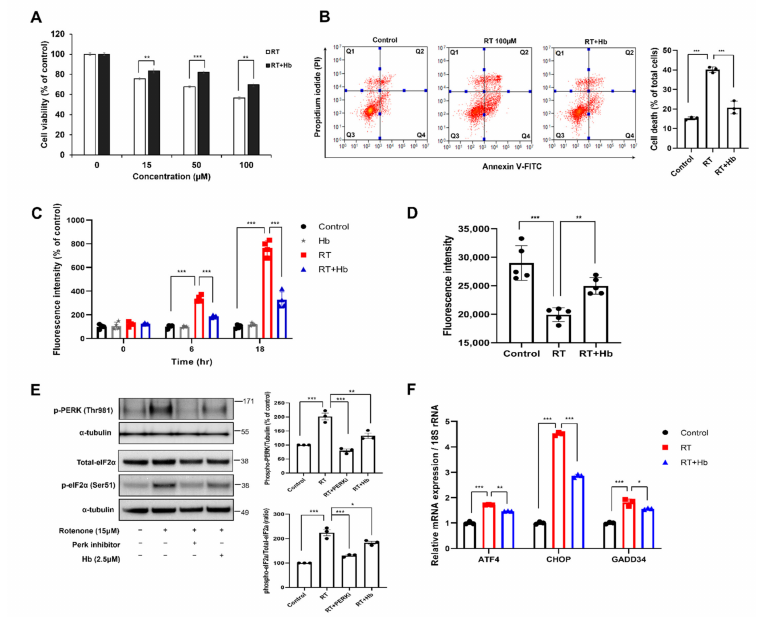
Figure 1. Hydroxocobalamin suppresses rotenone-induced PERK-eIF2 α phosphorylation in SH-SY5Y cells. ( A , B ) SH-SY5Y cells were pretreated with 2.5 µ M Hb for 30 min and then subsequently cultured with various concentrations of rotenone for 24 h. ( A ) Cell viability was measured using a CCK-8 assay. Data are presented as the mean percentages of untreated controls ± SD of three independent experiments. *** p < 0.001 (unpaired Student’s t test). ( B ) Representative flow cytometry plots obtained using Annexin V-FITC/PI staining for cell death analysis. Each cytogram was divided into four quadrants. Q1: Populations of Annexin-V-negative and PI-positive cells considered necrotic cells. Q2: Both Annexin-V-positive and PI-positive cells were marked and represent a later stage of apoptosis and necrosis. Q3: Negative for both Annexin-V and PI, indicating cells considered viable. Q4: Cells positive for Annexin-V and negative for PI that are presumed to be undergoing an early stage of apoptosis. The percentage of cell death is expressed as the sum of quadrants Q1, 2 and 4. Data are presented as the means ± SD of three independent experiments. Statistical analyses were performed using one-way ANOVA followed by Tukey’s multiple comparison test (*** p < 0.001). ( C – E ) SH-SY5Y cells were preincubated with Hb (2.5 µ M) for 30 min and subsequently treated with rotenone (15 µ M) for 18 h. ( C ) Intracellular ROS production was detected using the dye DCF-DA, and the results are reported as a percentage of the control by setting the sample fluorescence value of untreated cells to 100%. Data are presented as the means ± SD of three independent experiments. *** p < 0.001 (one-way ANOVA with Tukey’s multiple comparison test). ( D ) TMRE staining and analysis using a fluorescent plate reader. Error bars represent the mean values ± SD of independent experiments. The significance of differences was determined using one-way ANOVA with Tukey’s multiple comparison test (** p < 0.01 and *** p < 0.001). ( E ) Immunoblot analysis showing changes in the protein and phosphorylation levels of ER stress-related proteins following rotenone stimulation and treatment with Hb. For quantification, α -tubulin served as the internal control. The data are presented as the means ± SD of three independent experiments. ** p < 0.01 and *** p < 0.001 (one-way ANOVA with Tukey’s multiple comparison test). ( F ) SH-SY5Y cells pretreated with Hb (2.5 µ M) were treated with rotenone (15 µ M) for 8 h, and then real-time PCR was performed to assess the expression of ER stress-related genes. The mRNA levels are presented as the means ± SD of three independent experiments. 18S rRNA was used for normalization. * p < 0.05, ** p < 0.01, and *** p < 0.001 (one-way ANOVA with Tukey’s multiple comparison